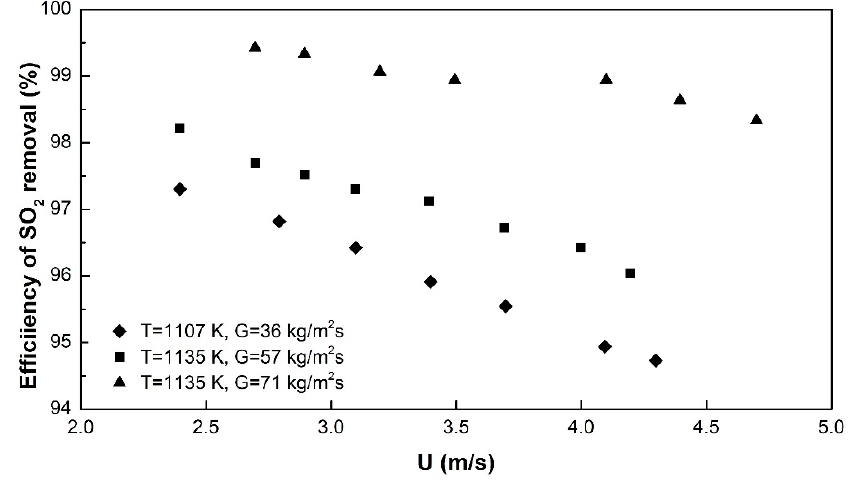
Figure 5. Experimental data under different conditions, at d p = 40 μ m.